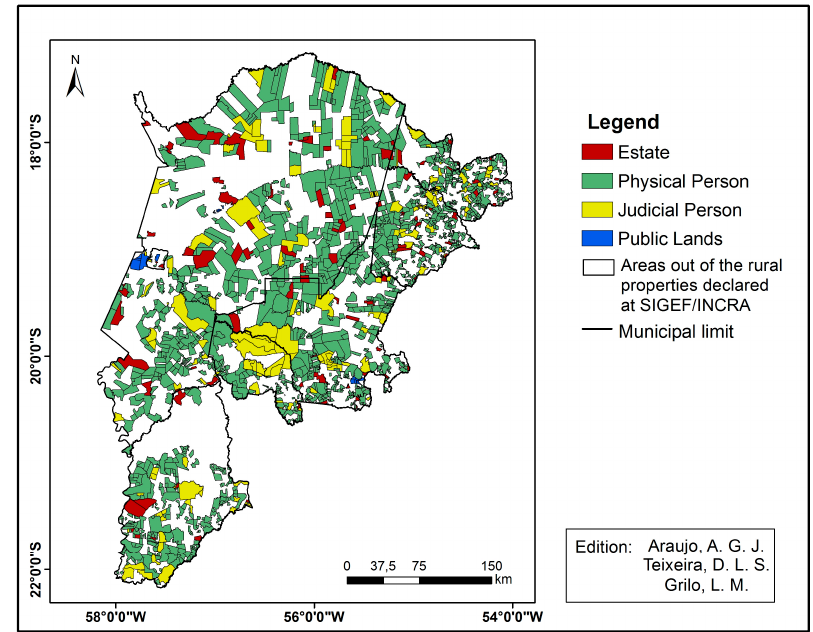
Figure 4. Rural properties in the municipalities of the South Pantanal according to the administrative profile. Source: Araujo (2018).